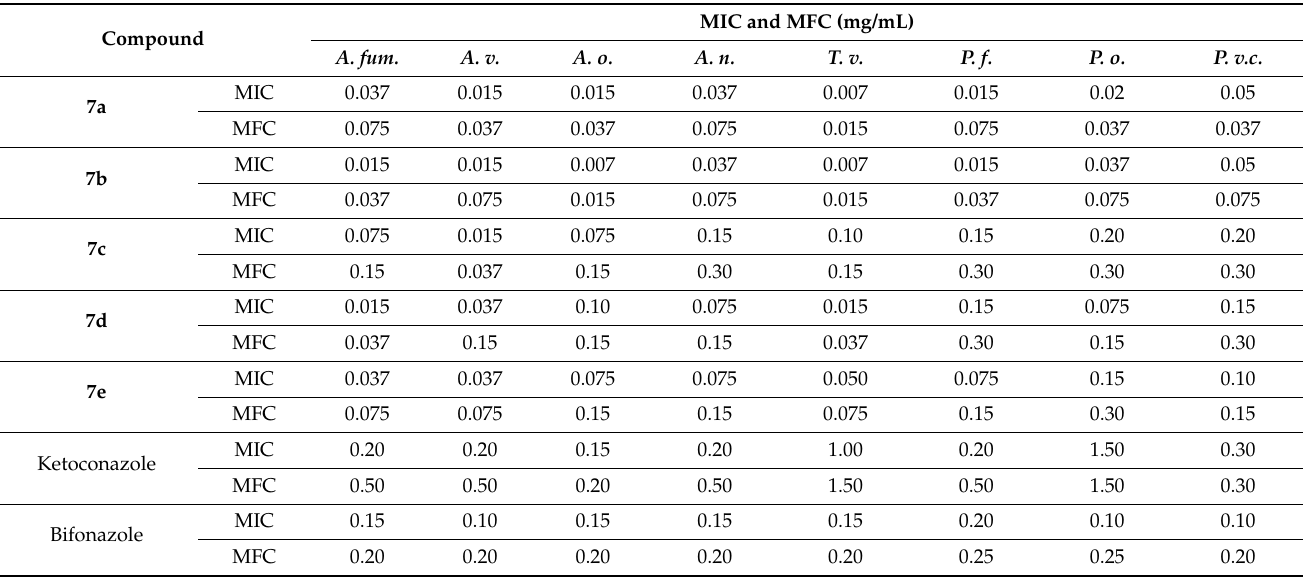
Table 9. MIC and MFC (mg/mL) values of the synthesized androstane oxime derivatives. Adapted from